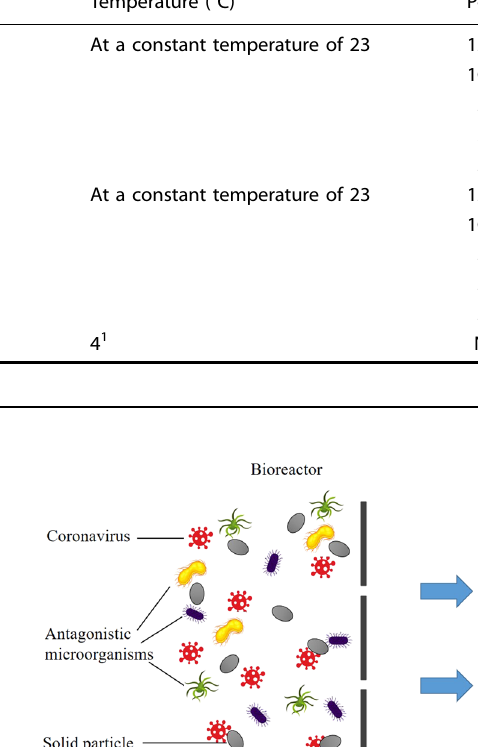
Table 5. The effect of organic matter on the persistence of coronavirus in different water matrices.